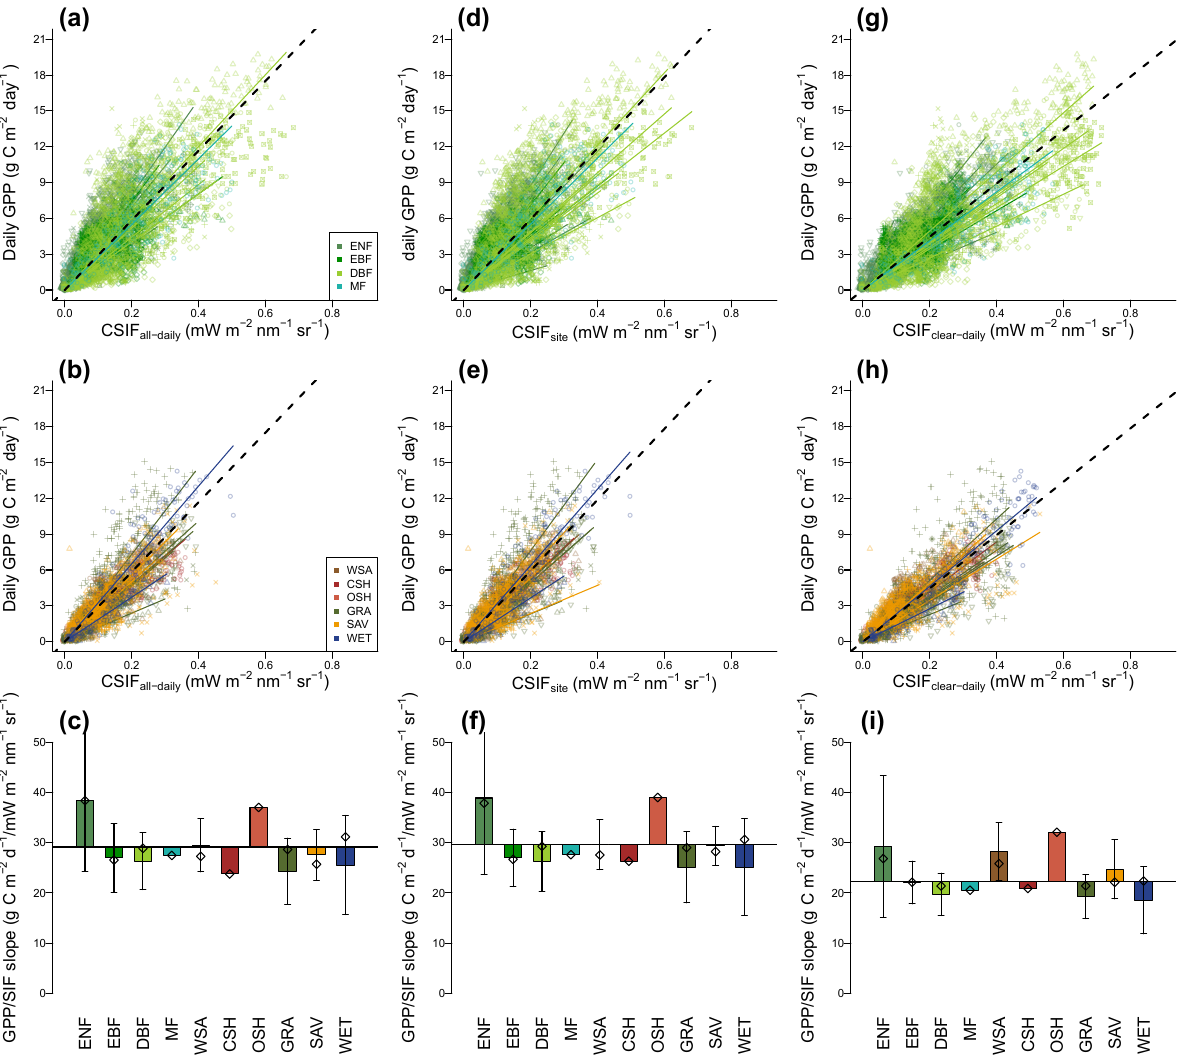
Figure 13. Comparison between GPP estimates from 40 EC flux towers and CSIF all-daily (a–c) that uses BESS PAR, CSIF site (d–f) that uses site-measured radiation and CSIF clear-daily (g–i) that assumes clear-sky condition. The 40 sites were grouped into forests (a, d, g) and non-forests (b, e, h) . Color–symbol combinations represent different sites. Summary of the regression slopes between GPP and CSIF for different land cover types (c, f, i) . The baseline (dashed black lines) was calculated using all samples (29.71 for CSIF all-daily , 29.18 for CSIF site and 22.33 for CSIF clear-daily ). Error bars represent the standard deviation of slopes across sites within this biome type. Rhombuses represent regression for each biome type when data from all sites were